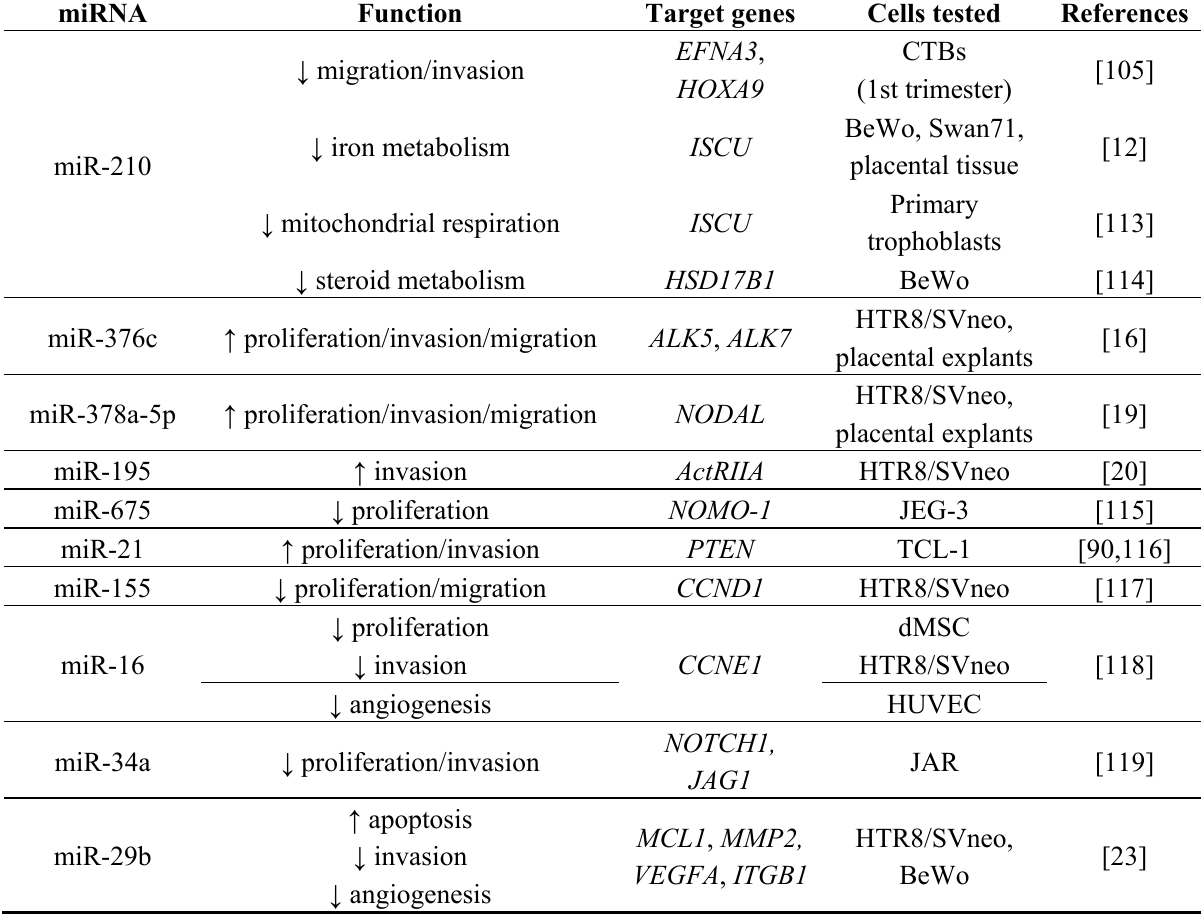
Table 1. The function and targets of MicroRNAs (miRNAs) in trophoblast.